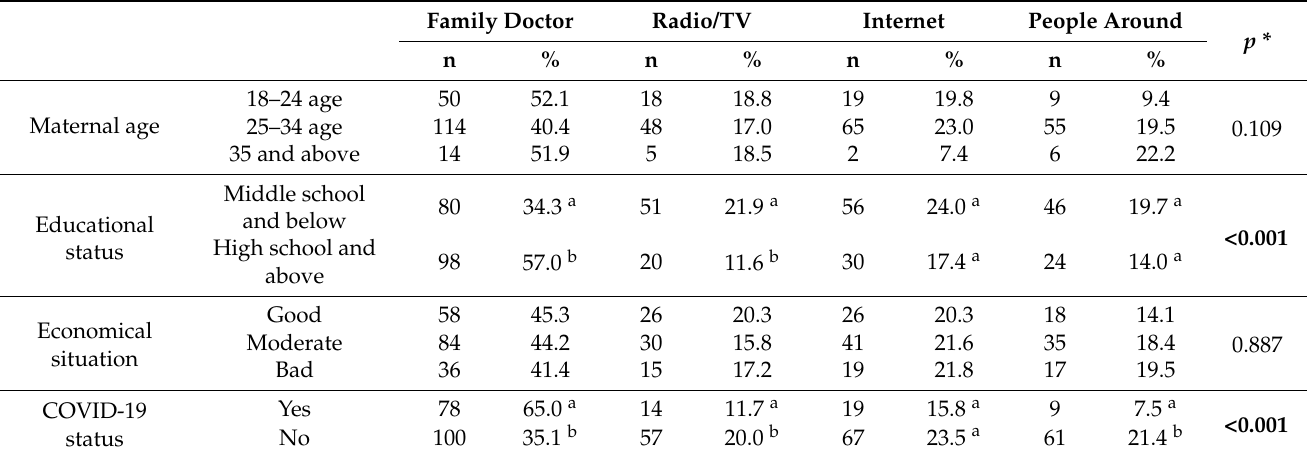
Table 5. Comparison of information sources of various